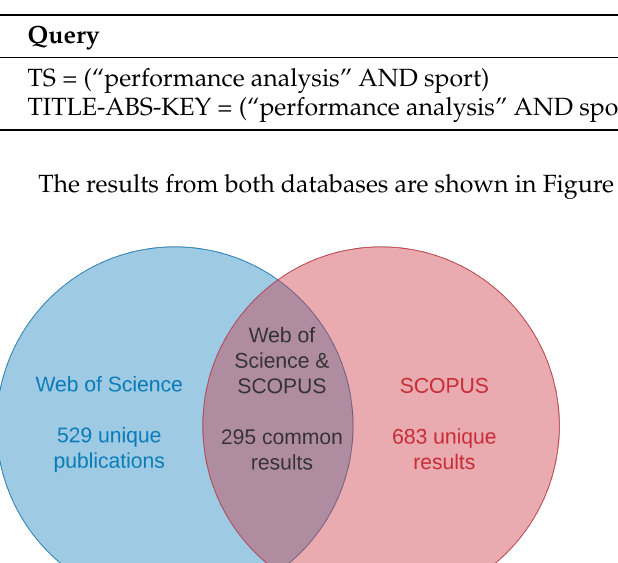
Table 1. SCOPUS and WoS databases search queries.